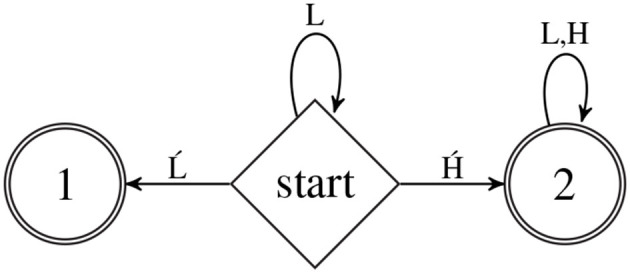
The dfa
ALHOR is the basis for the case study in section 8.